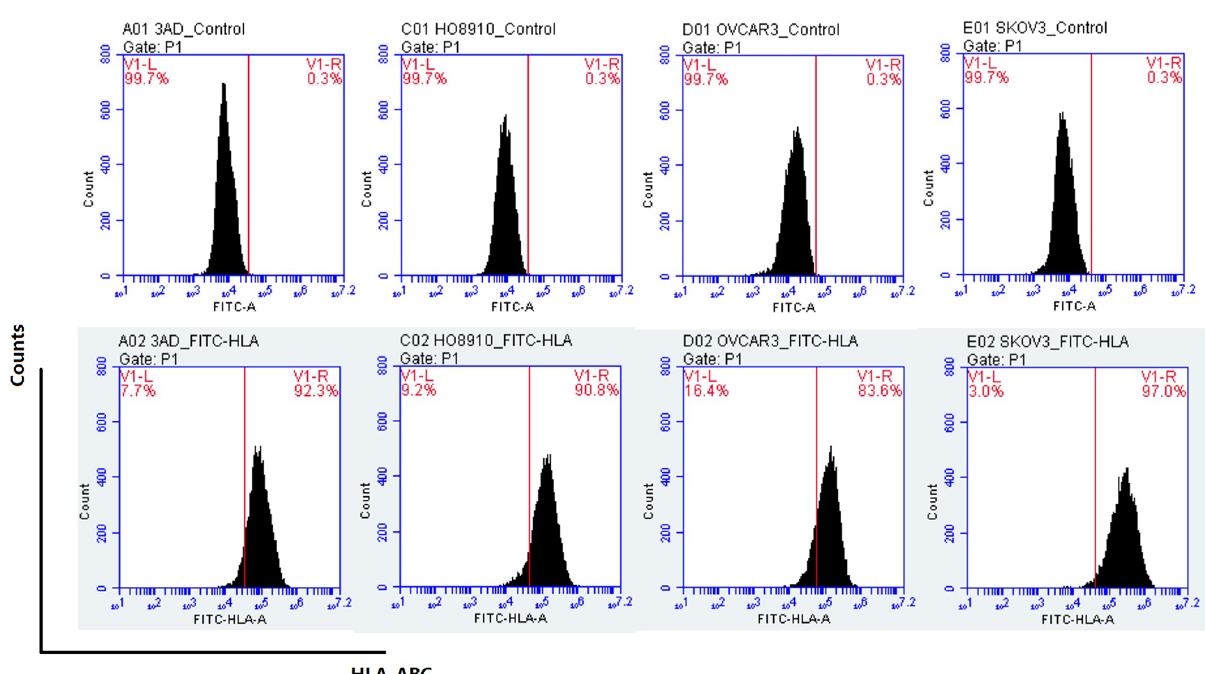
Fig 8. Detection of the expression of HLA-I molecules on ovarian cancer cell surface by HLA-ABC antibody. The upper panel shows the control without additionof HLA-ABC antibody.